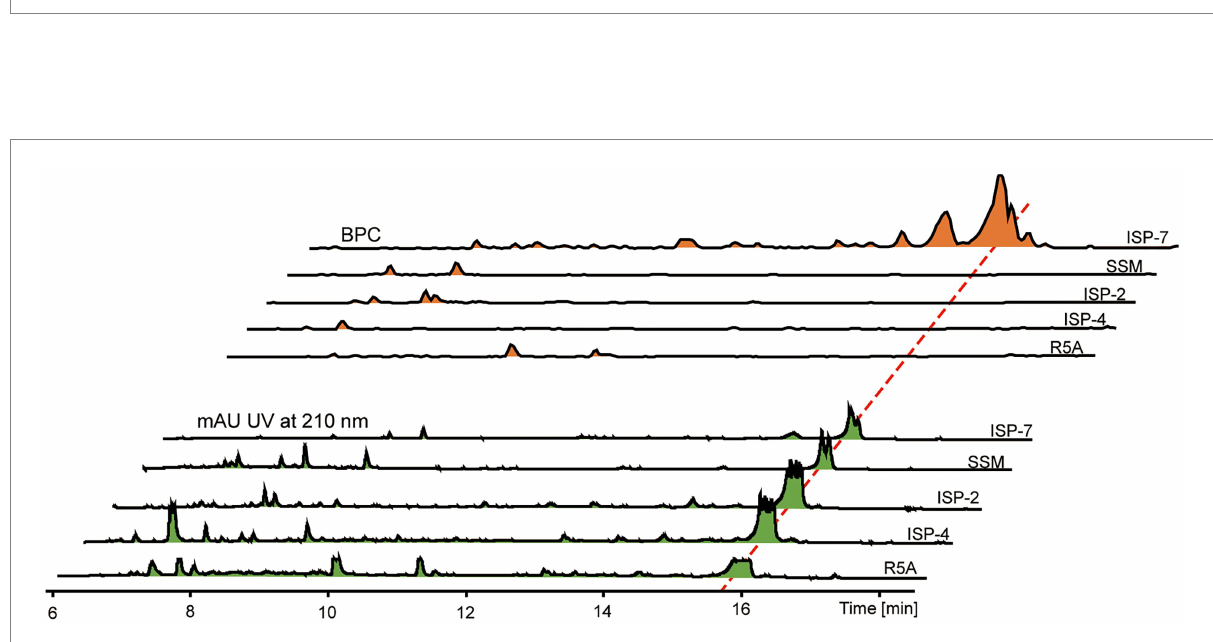
FIGURE 2 HPLC-MS data of crude extracts of Streptomyces sp. sdu1201 cultured in different